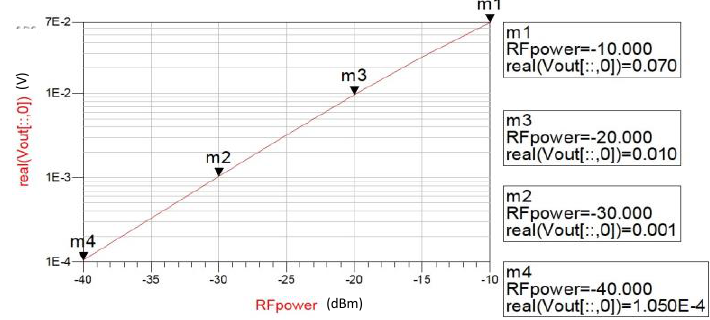
Figure 10 : The harmonic balance simulation results at 170 GHz